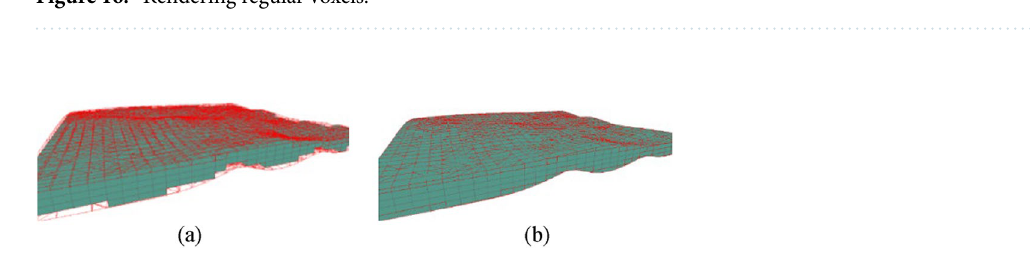
Figure 17. Render irregular voxels.